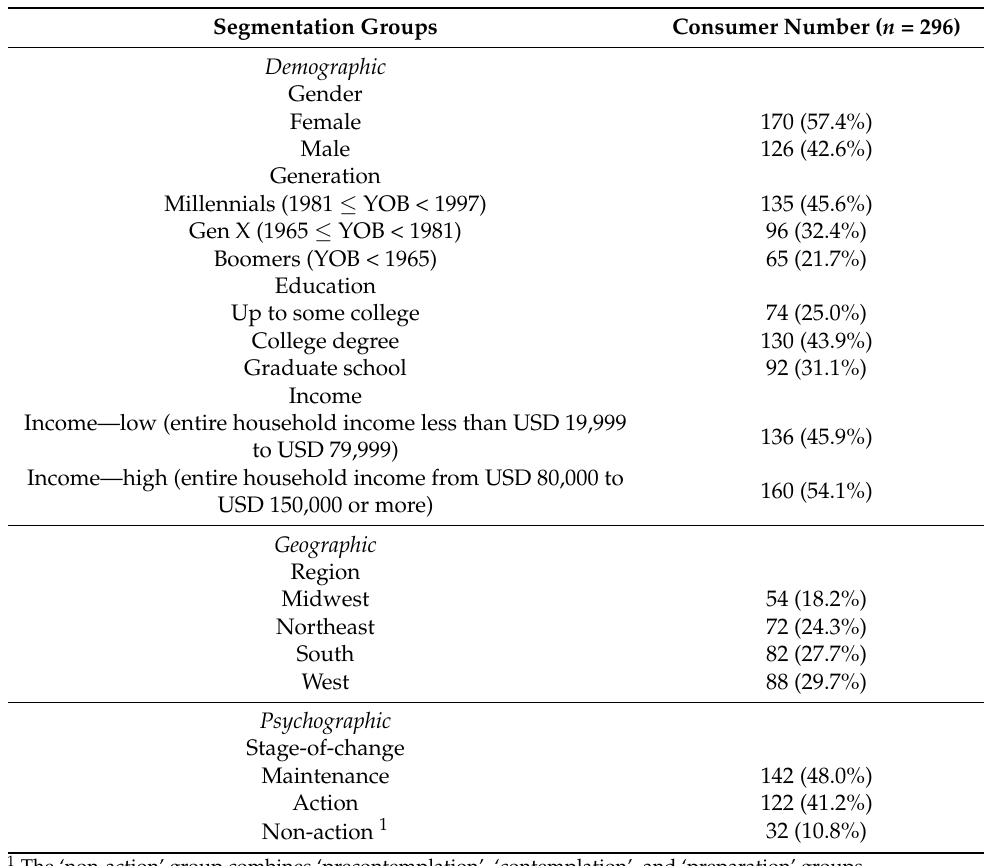
Table 1. Consumer segmentation characteristics of the survey participants.